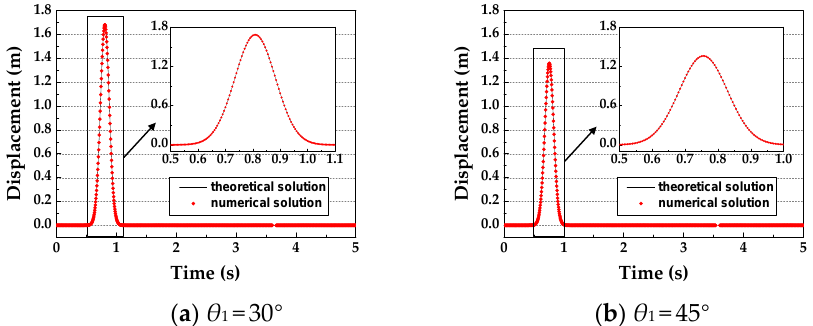
Figure 6. Time history of vertical displacement at point O.